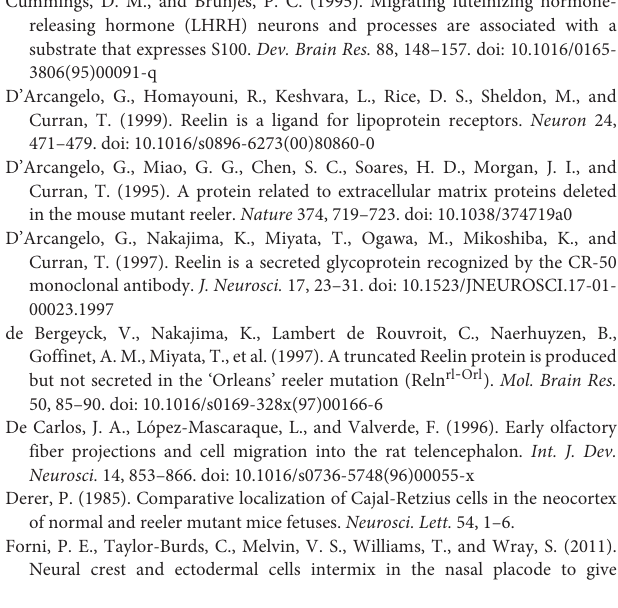
FIGURE S1 | Disabled 1 (Dab1) transcripts are preset in gonadotropin releasing hormone-1 (GnRH) cells and olfactory ensheathing cells (OECs). Top panel: band of the correct size (164 bps) for Dab1 was detected in cDNA produced from eight individual GnRH cells. Bottom panel: The purity of the OECs was confirmed by PCR for p75 (OEC positive, product size: 264 bps) and myelin basic protein (OEC negative, 282 bps). Like GnRH cells, OECs were positive for Dab1 transcript. Br = Brain (positive control), H 2 0 = water (negative control).